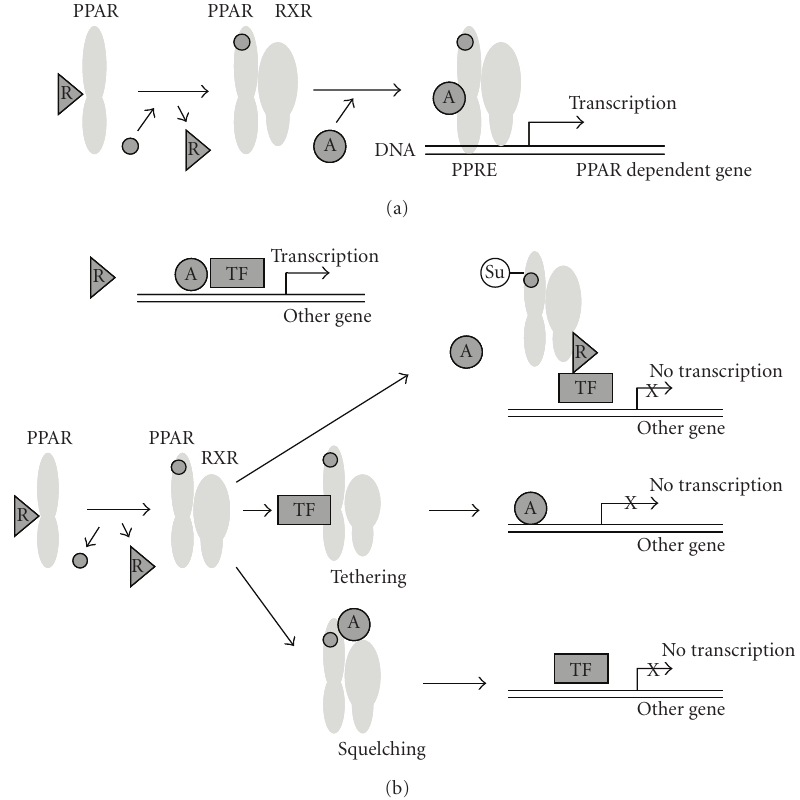
Figure 2: General Schematics of PPAR function. General mechanisms of (a) genomic expression and (b) transrepression of gene expression by PPAR/RXR heterodimers. In (a), upon ligand binding PPAR associates with RXR and coactivator to turn on target genes via the PPAR response element (PPRE). In (b), blocking the dissociation of corepressor from transcription factor at the gene locus, association of transcription factor to PPAR/RXR by tethering, and association of coactivator with PPAR/RXR by squelching, inhibit the transcription of di ff erent genes. R = corepressors, filled circle = ligand, A = coactivators, TF = transcription factor. Su indicates modulation by small regulatory protein